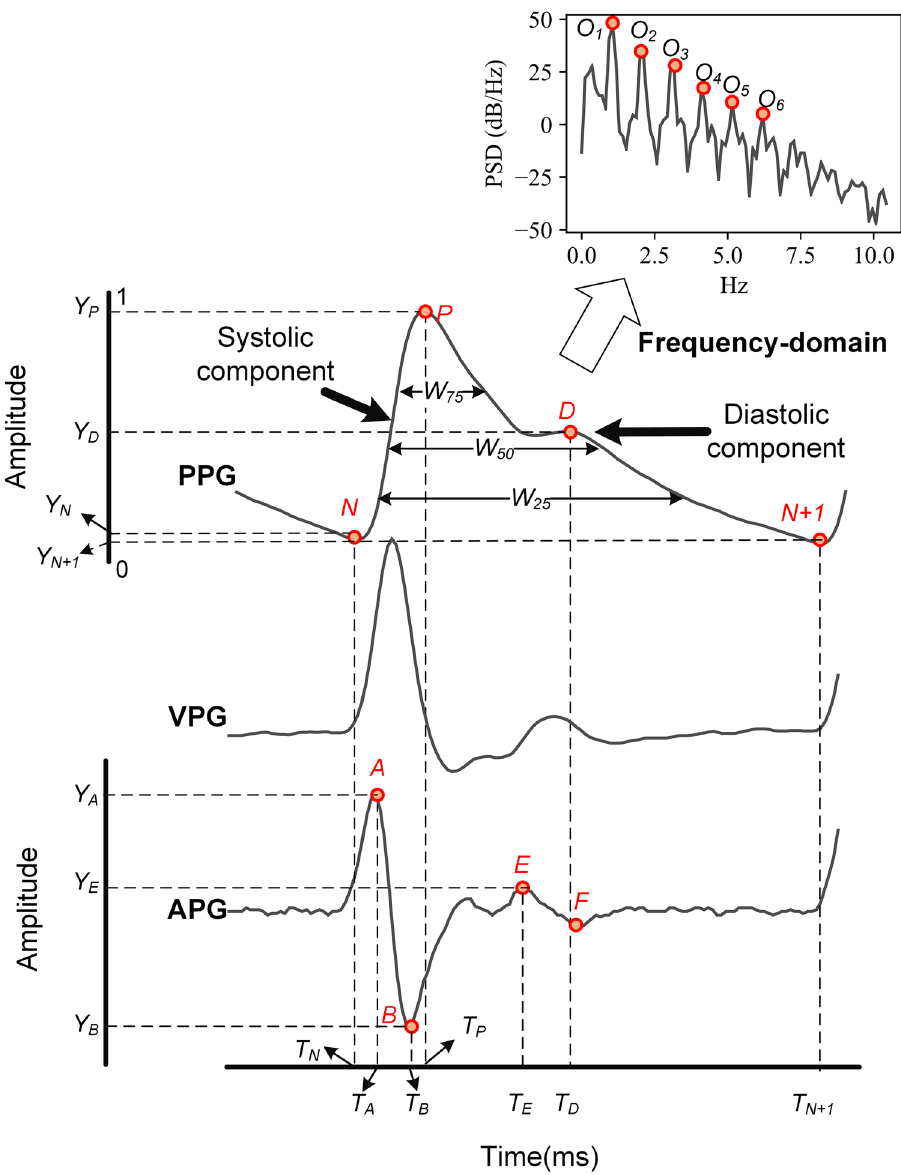
Figure 1. PPG, the first derivative of PPG (VPG), the second derivative of PPG (APG) signal and their features. The abbreviations T and Y denote the time (ms) and amplitude of the corresponding points,